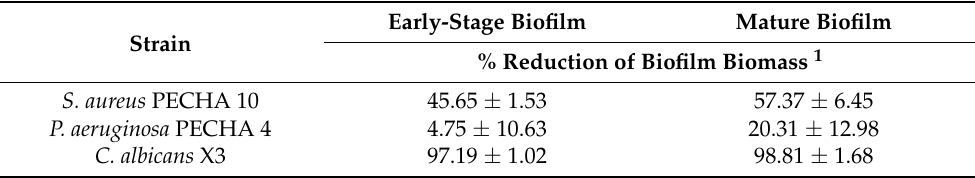
Table 2. Reduction of monomicrobial biofilm biomass after treatment with